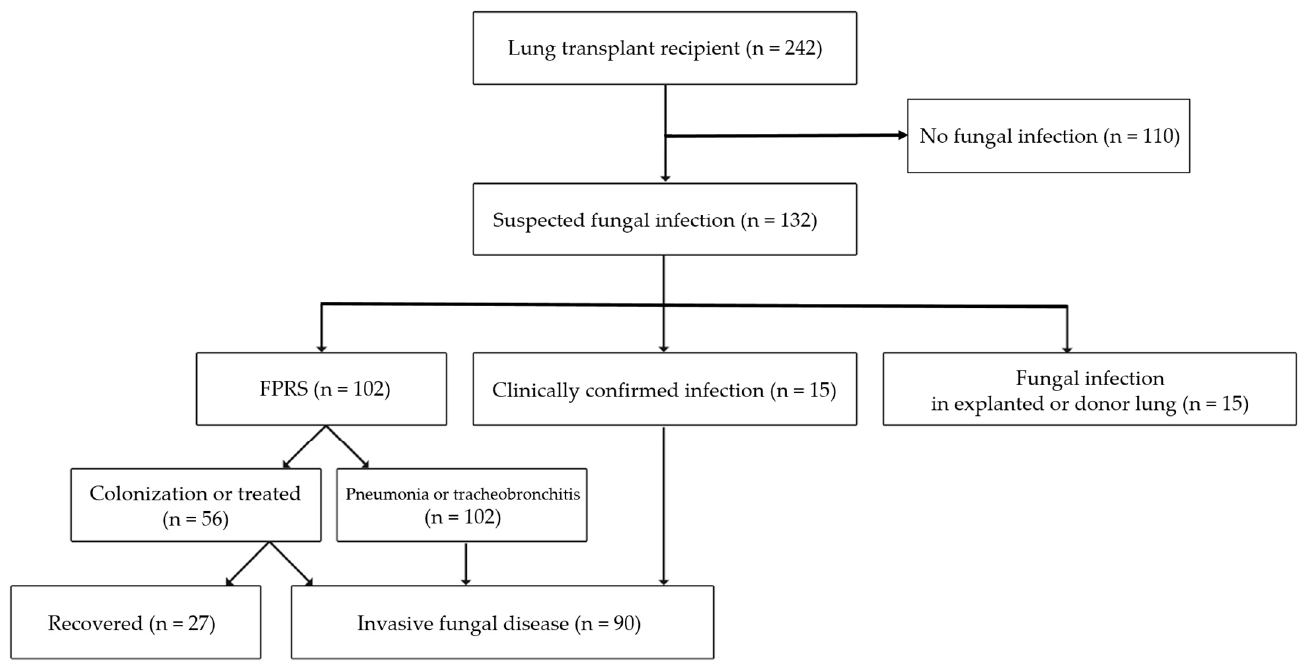
Figure 1. Summary of the study design. FPRS, fungus-positive respiratory